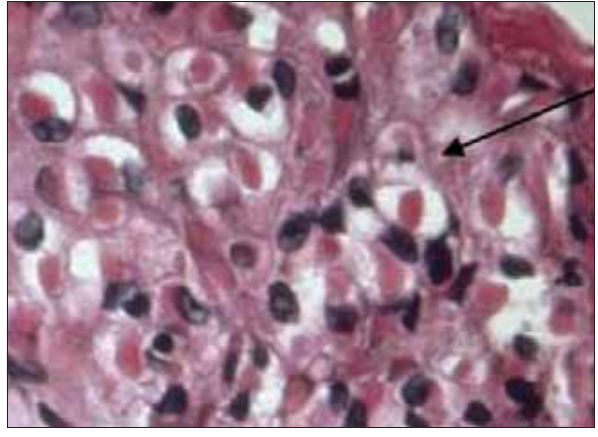
Figure-6: Chorioallantoic membrane showing intra- cytoplasmic inclusion bodies